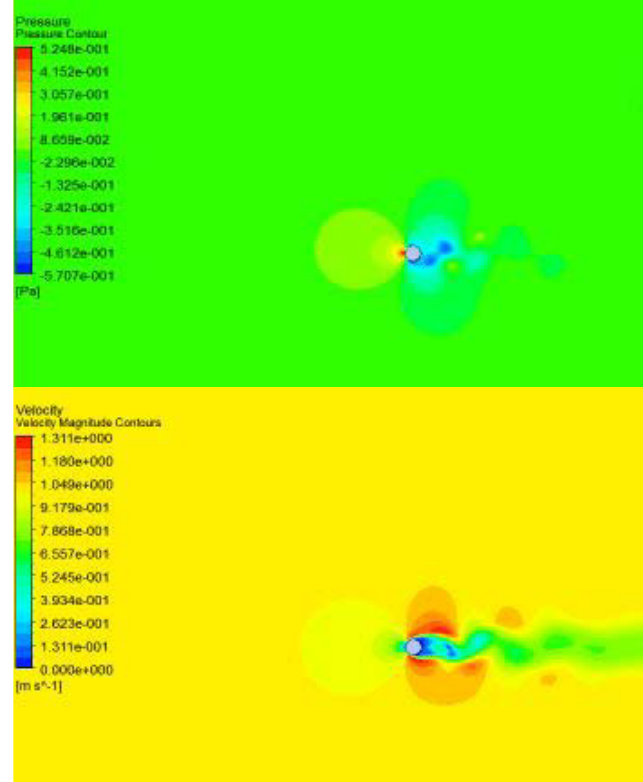
Fig. 4. Pressure, velocity contours for circle section of cable for